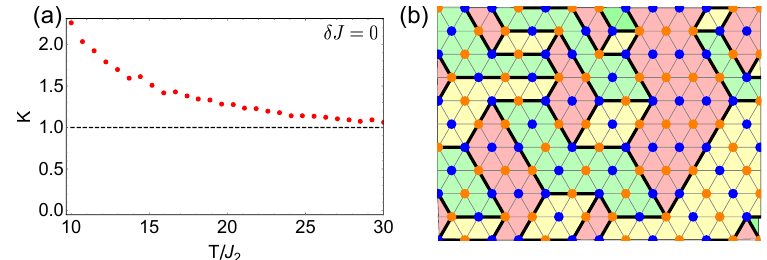
Figure 31: String Luttinger liquid and domain-wall network states. (a) The String Luttinger liquid is characterised by the parameter, K , and this is determined from Monte Carlo simulations of an L = 72 hexagonal cluster by fitting S ( r ) with the asymptotic form given in Eq. 90. This type of fitting breaks down at T ≈ T tri = 9.14 J (b) Snapshot of a domain-wall network configuration, taken from a Monte 2 Carlo simulation at δ J = 0 and T = 6.5 J . Domains have stripes parallel to A (red), B (green) or C 2 (yellow) bonds. A domains correspond to an absence of strings while B and C domains to parallel neighbouring strings, and this type of configuration is driven by string-string